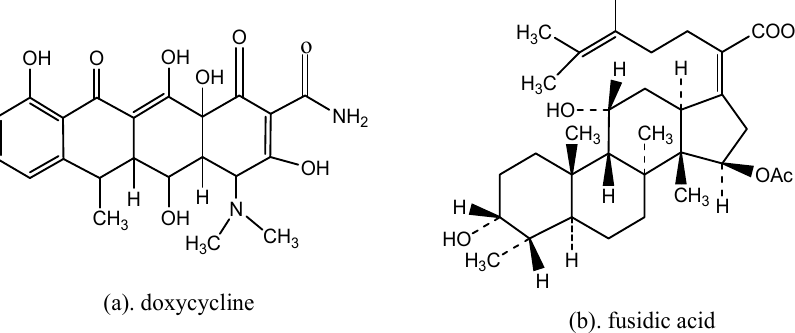
Figure 8. The structural of positive control drugs ( a , b ). ( a ) doxycycline (broad-spectrum antibiotic) and ( b ) fusidic acid (antibiotic of Gram-positive cocci infection).